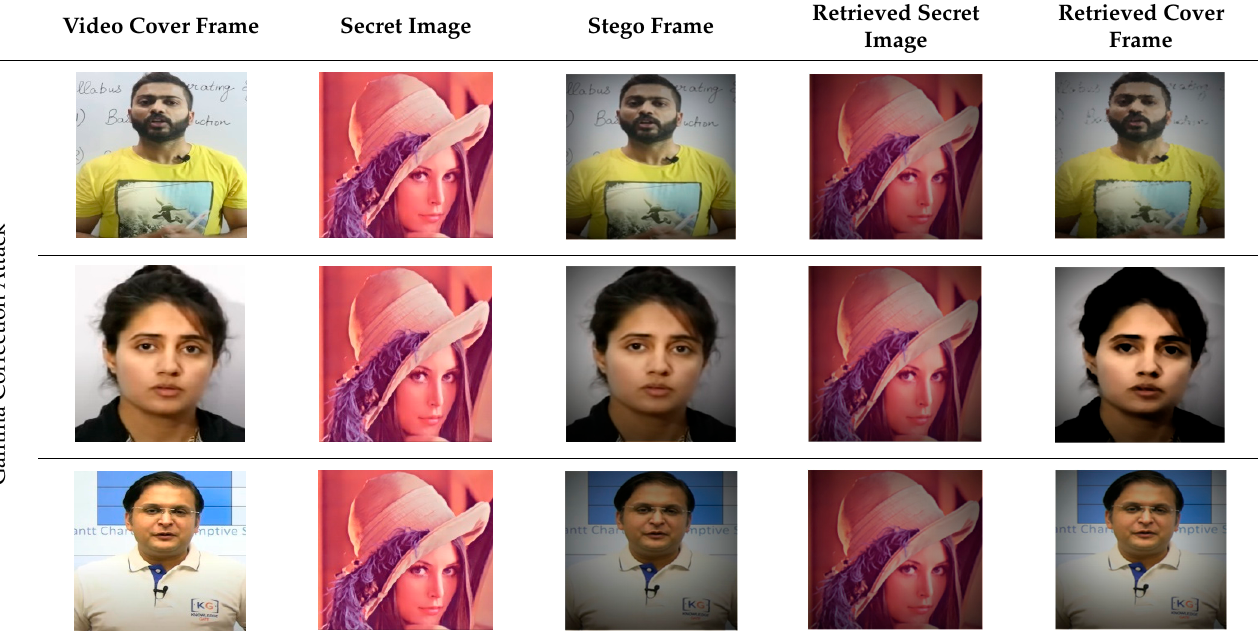
Table 3. Gamma Correction Attack.